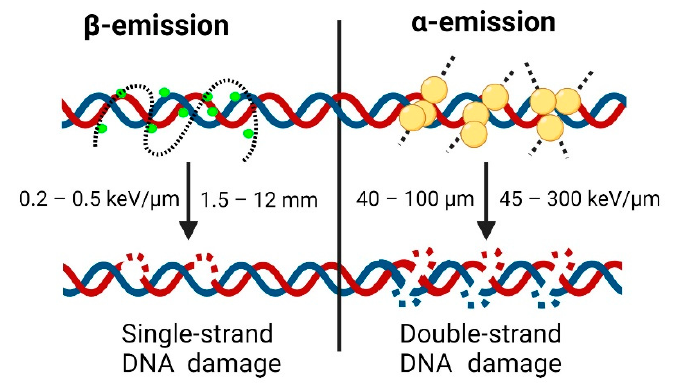
Figure 3. Schematic drawing showing differences between β - -and α -emission. The β - -emission is less focused, with a longer range and lower LET, leading to single-strand DNA damage. The α - emission is highly energetic, focused and short in range, causing double-strand DNA